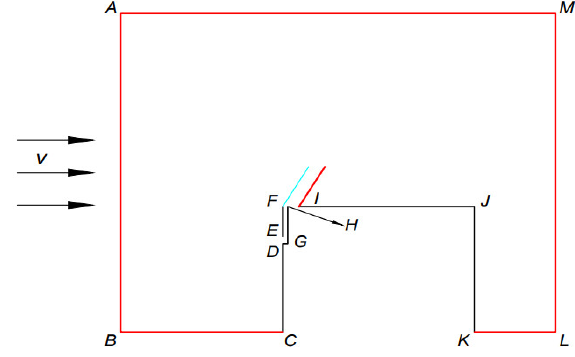
Figure 2. Calculation domain of the solar chimney.